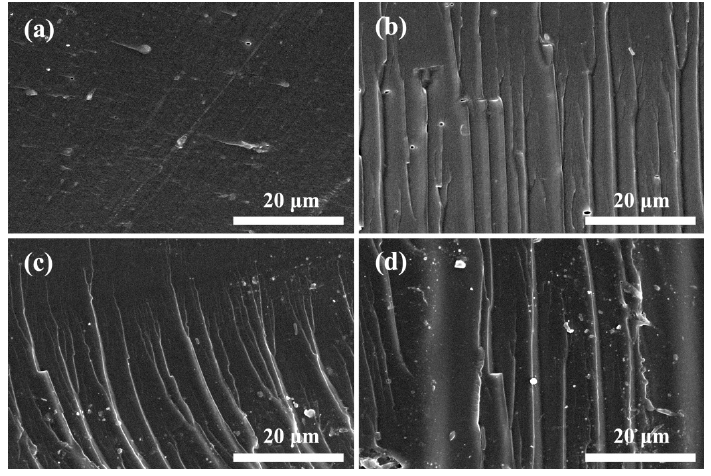
Figure 4. SEM micrographs of SPI film and SPI-based films modified with graphene, CNC, and PCNC.